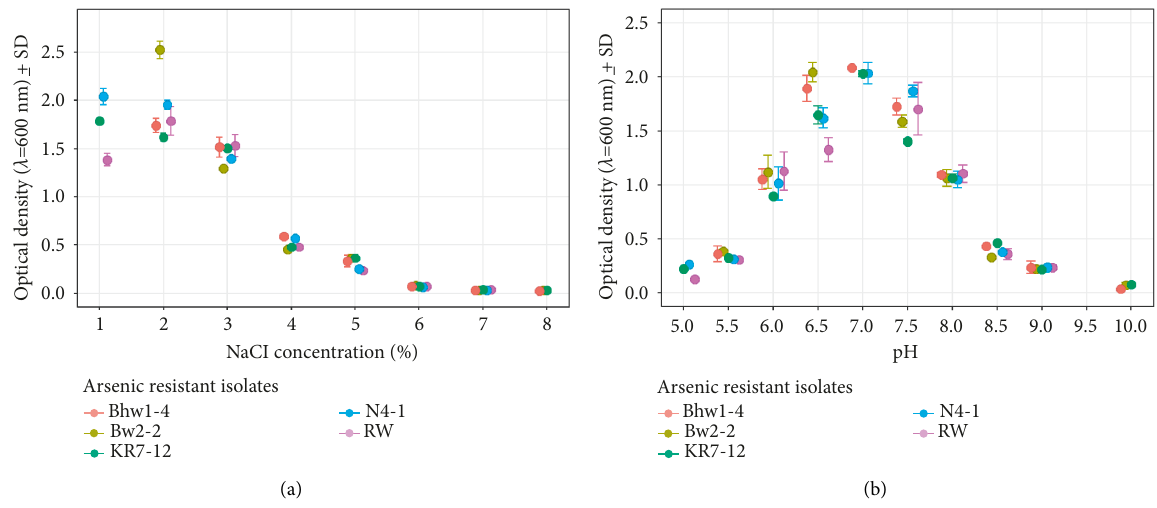
Figure 5: Growth of arsenic-resistant isolates under different NaCl concentrations (a) and pH values (b).